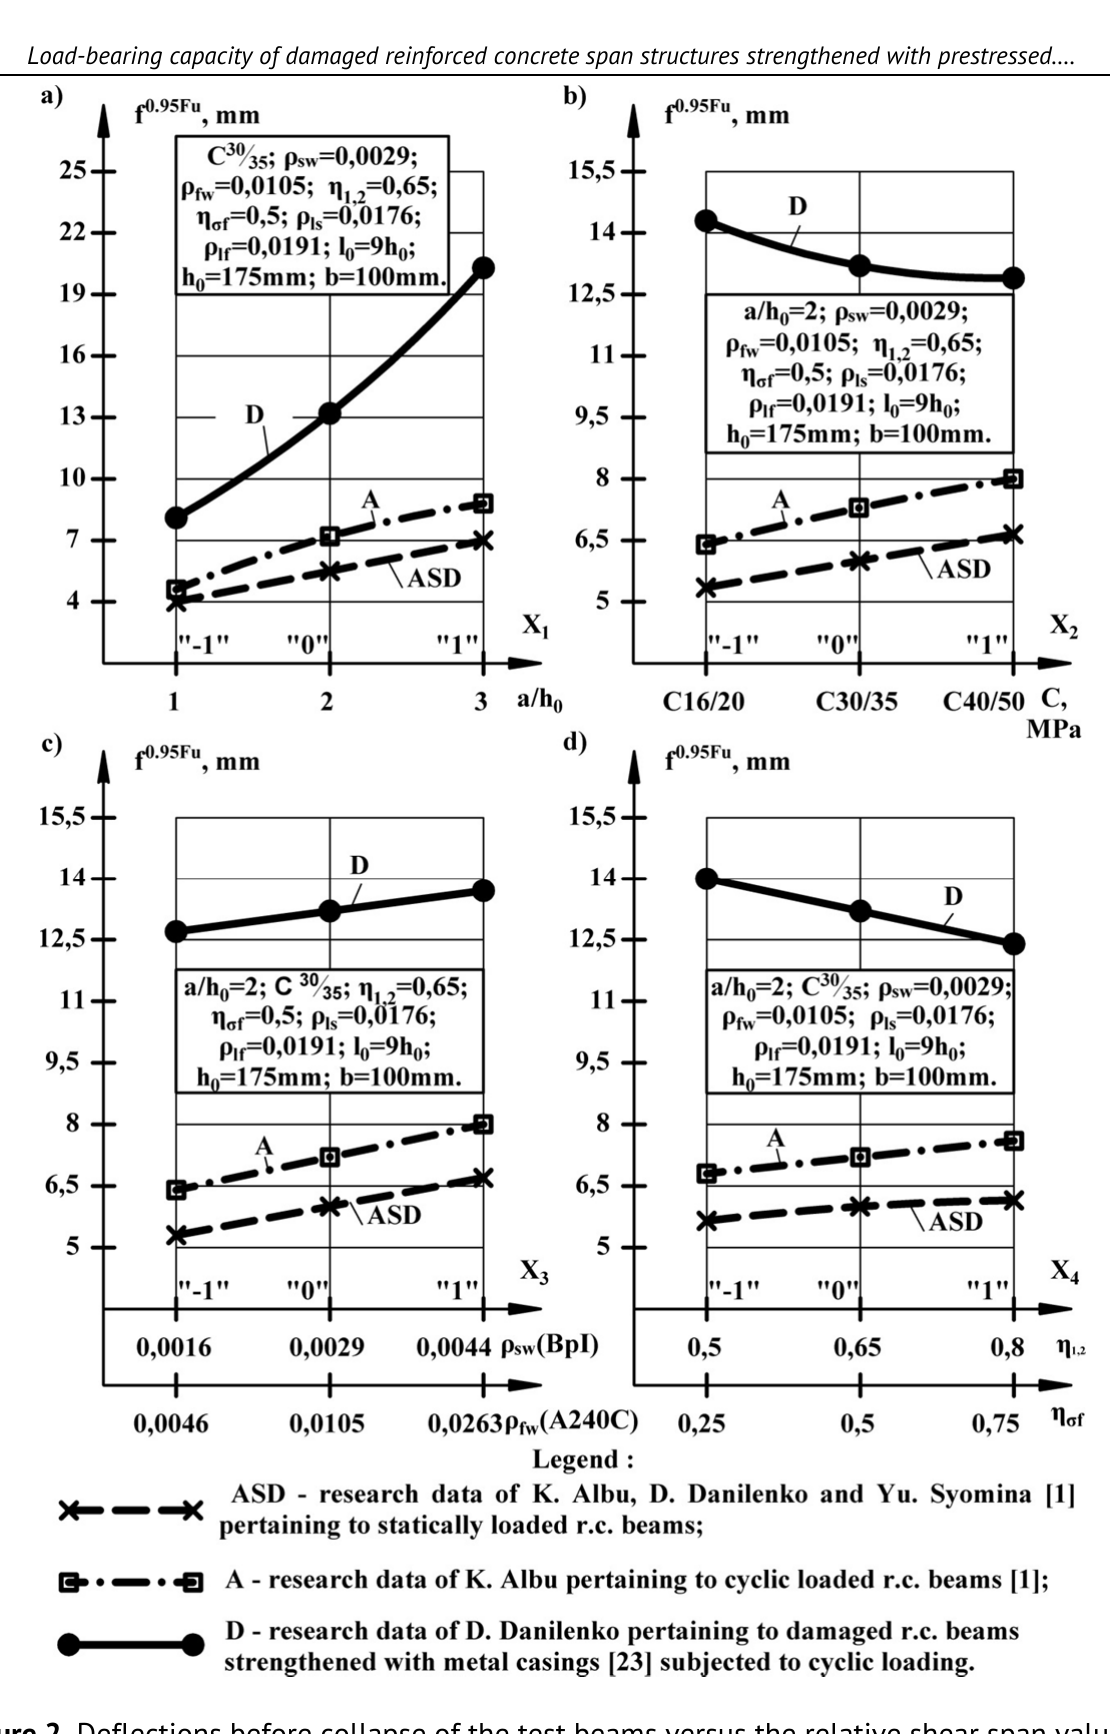
Figure 2. Deflections before collapse of the test beams versus the relative shear span value (a), concrete grade (b), transverse reinforcement quantity (c) and levels of transverse loading and prestress of the metal plate elements